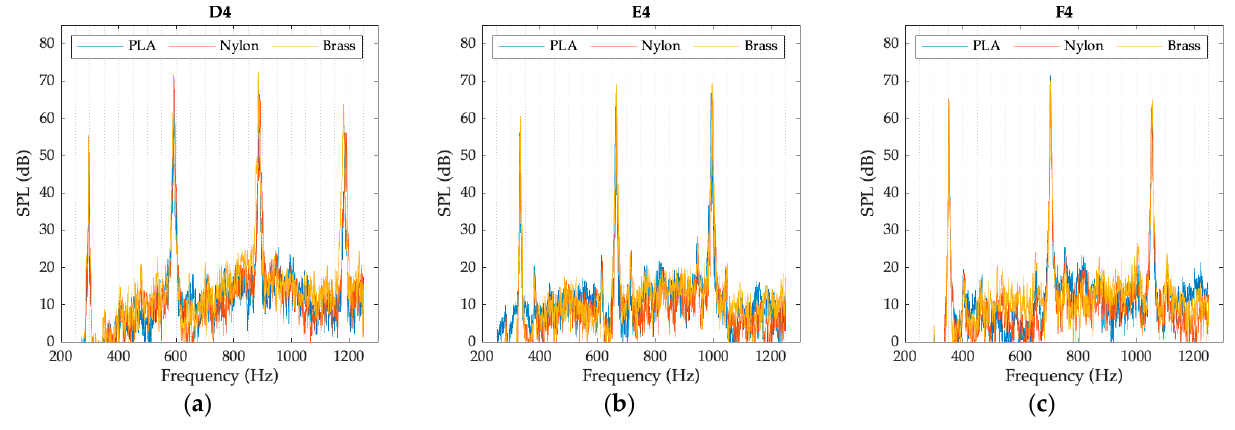
Figure 9. Mid register spectrum for each mouthpiece: ( a ) E3 note; ( b ) F3 note; ( c ) G3 note.